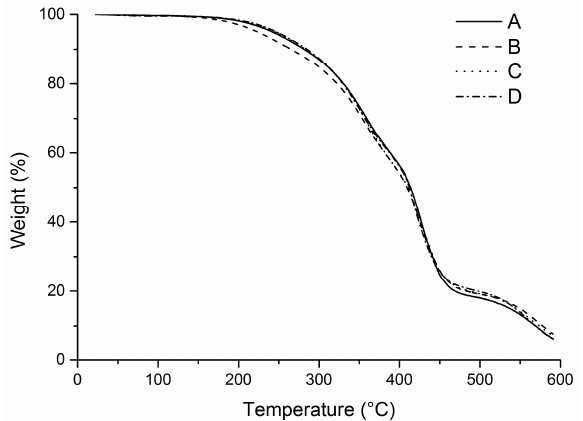
Figure 10. Thermogravimetric Analysis (TGA) curves of dried latexes containing 200 mg of total monomer weight with ( A ) 80 wt.% of tung oil, ( B ) 70 wt.% of tung oil, ( C ) 55 wt.% of tung oil, and ( D ) 40 wt.% of tung oil. All samples were subjected to an initial cure step at 100 °C for 24 h, followed by